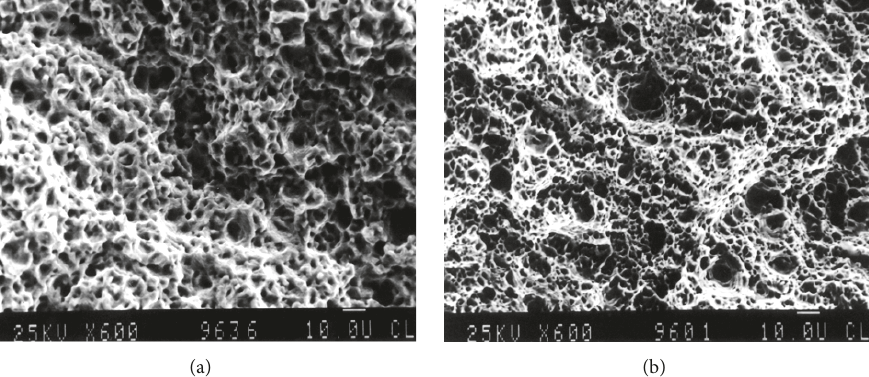
Figure 9: Fracture surface. (a) C16E after creep exposition at 450 ∘ C, 7120 h; (b) H300LAD after creep exposition at 450 ∘ C, 8930 h.